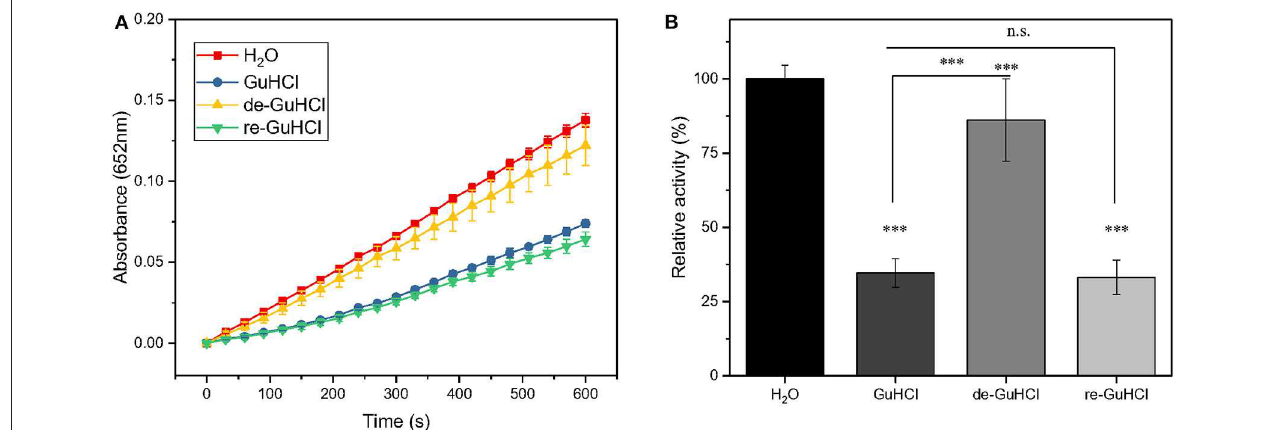
FIGURE 2 | GuHCl is a reversible inhibitor of IONzyme. The peroxidase activity of recycled IONzyme was analyzed and shown by the dynamic changes in the absorbance (A) and the relative activity (B) . Conditions are shown in Figure 1 . Samples included the untreated IONzyme control (H 2 O), IONzyme mixed with GuHCl (GuHCl), recycled IONzyme after the removal of GuHCl (de-GuHCl), and the de-GuHCl sample with GuHCl re-added (re-GuHCl) ( n ≥ 12). Data are the mean ± SD. *** P < 0.001, No significance (N.S.), P > 0.5.